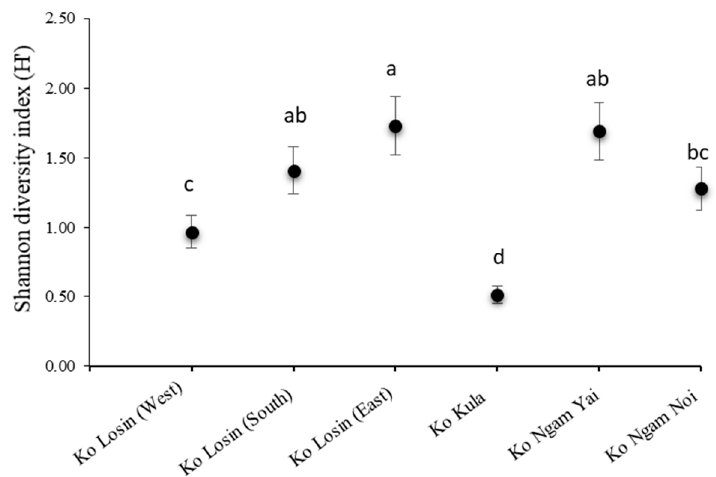
Figure 4. Species composition of corals at the study sites. Error bars indicate standard deviation.